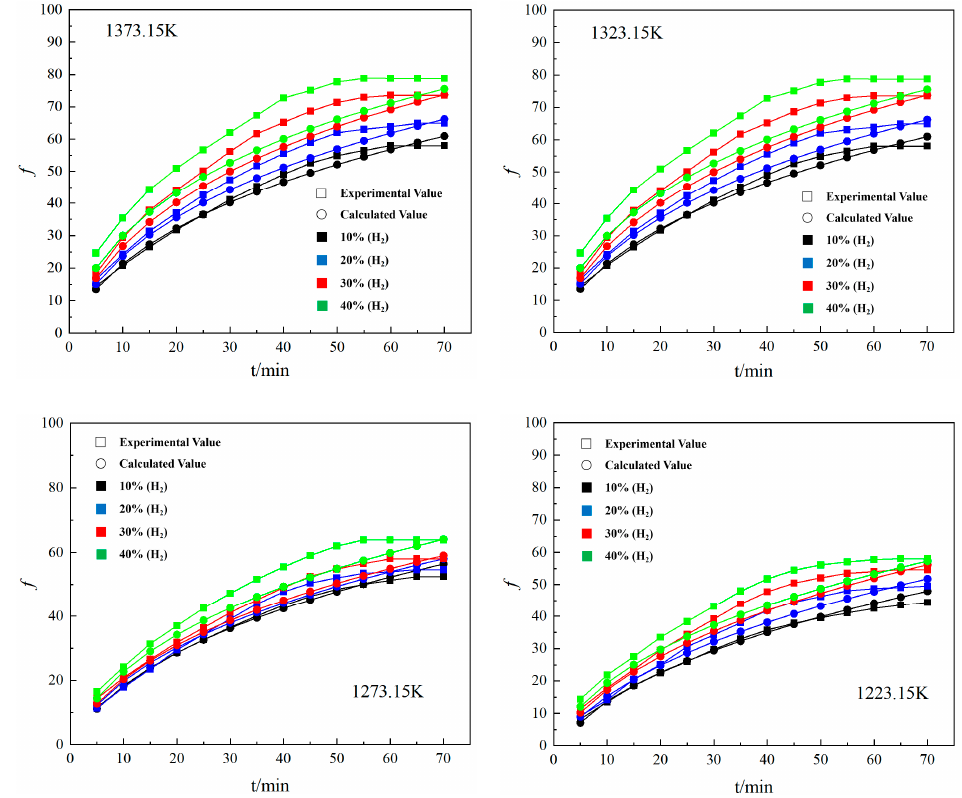
Figure 14. Comparison between the theoretical and experimental data for the reduction .